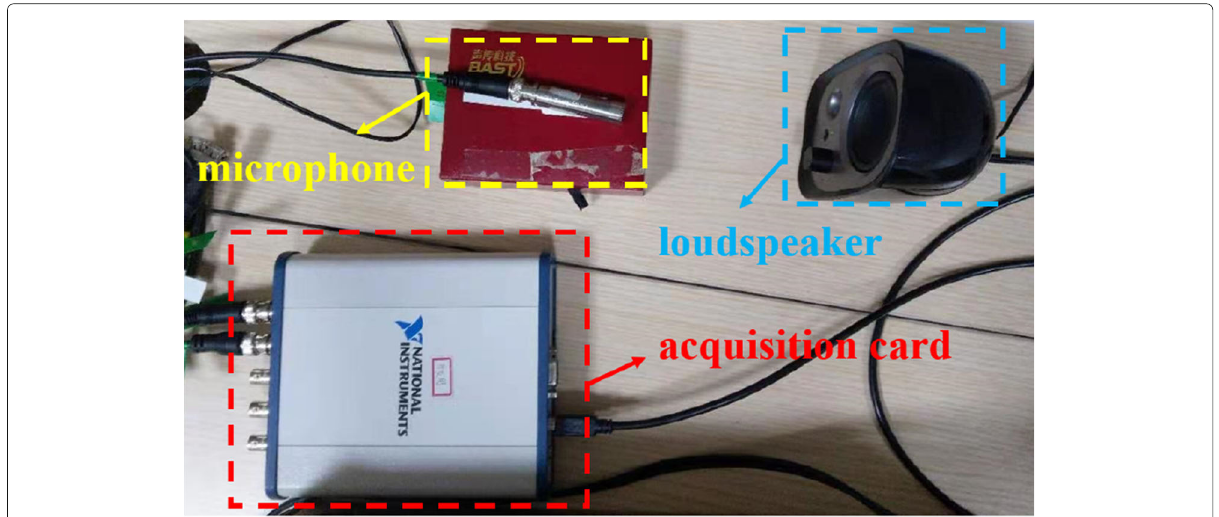
Fig. 6 The photo of the experiment site where we record the echo